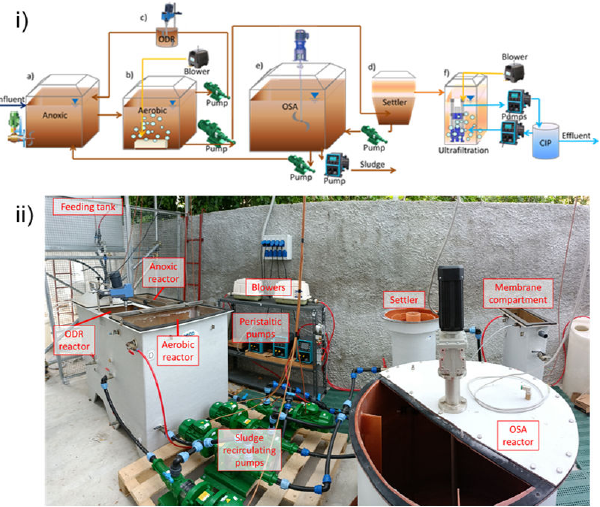
Figure 4. ( i ) CAS-OSA pilot plant configuration. ( a ) anoxic reactor, ( b ) aerobic reactor, ( c ) oxygen